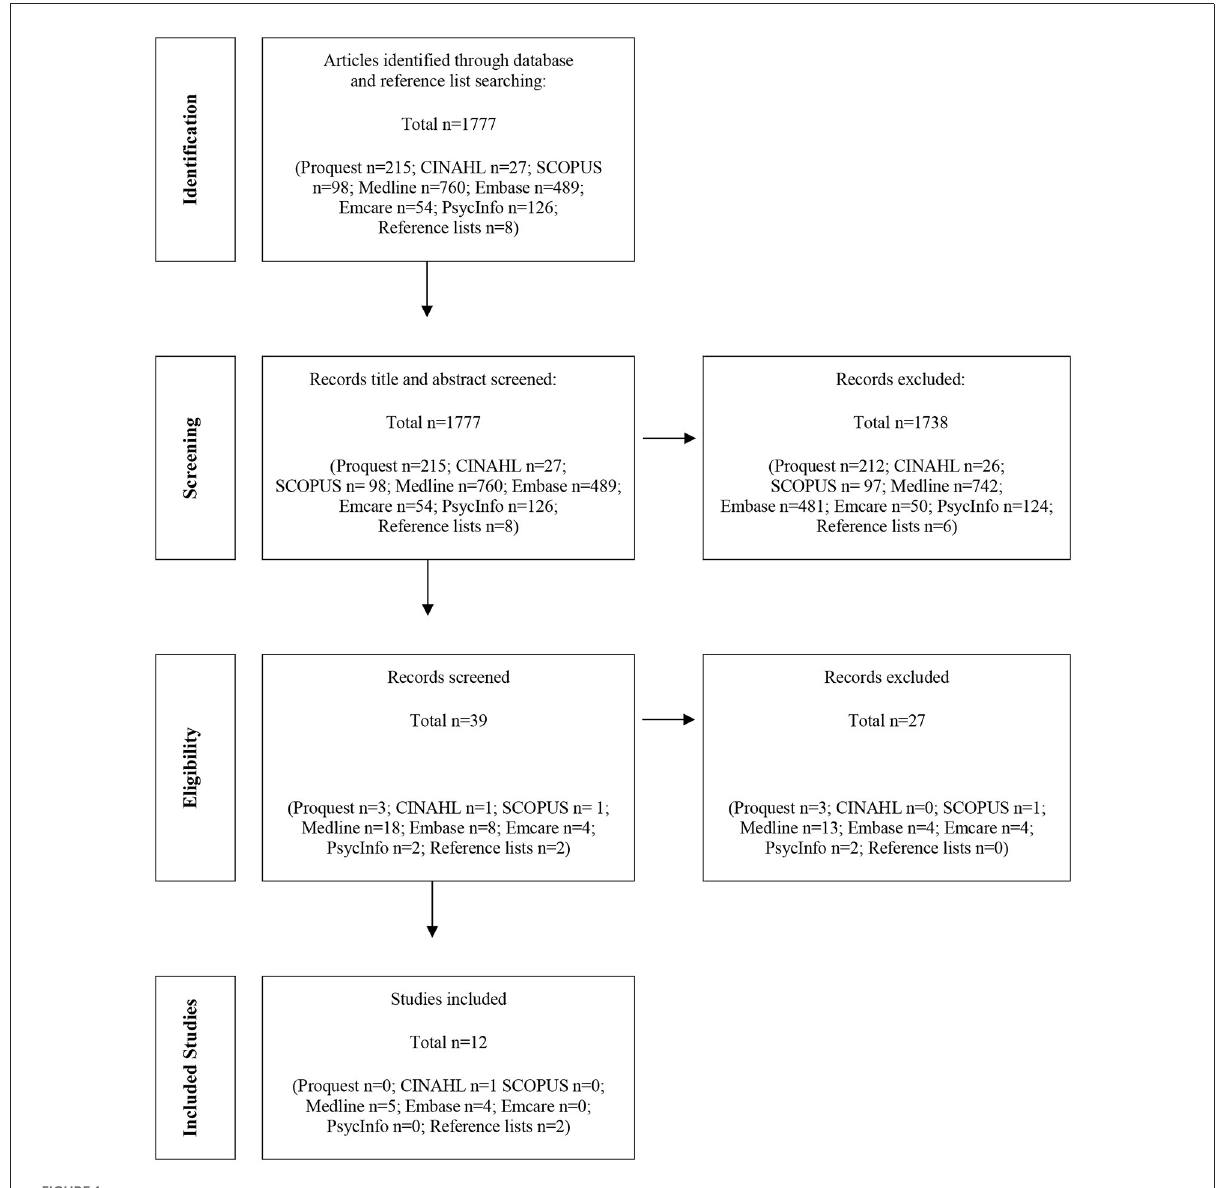
FIGURE1 PRISMA flow diagram of articles through the study